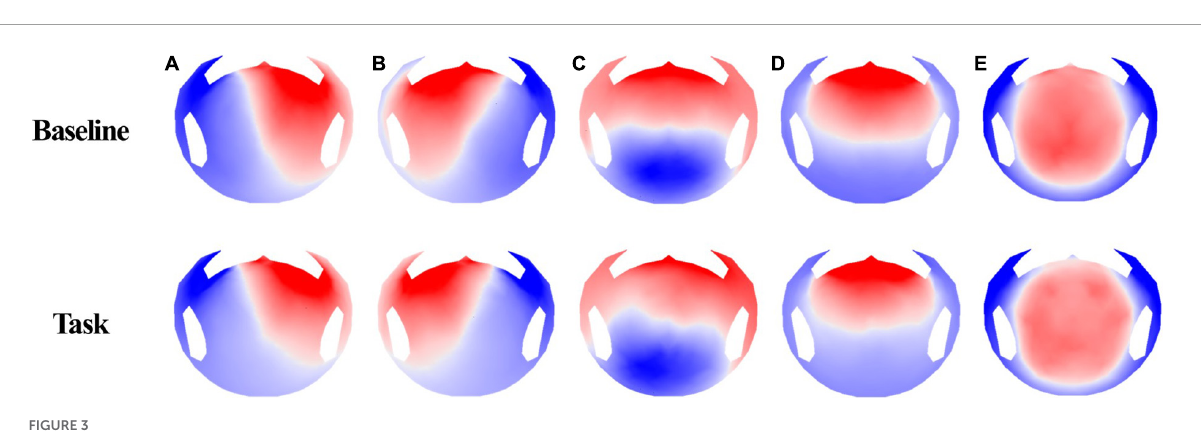
FIGURE3 EEG microstate topographies for both conditions (base,